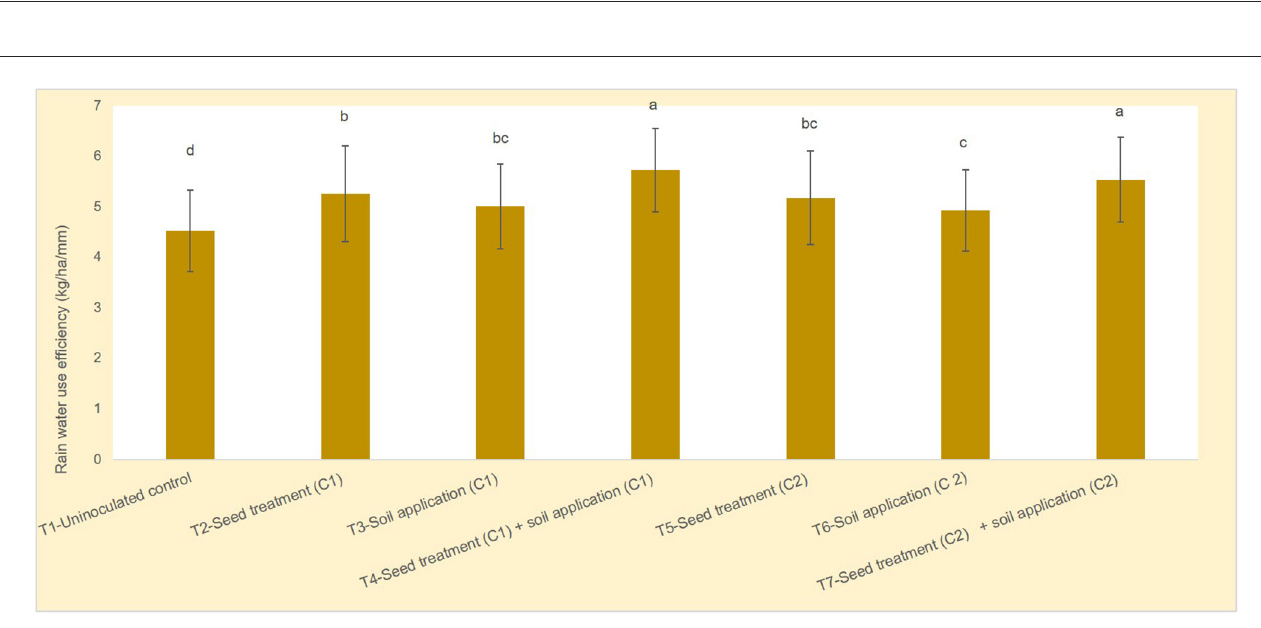
FIGURE2 Effect of microbial consortia on rain water use efficiency of maize. p = 0.00; error bars indicate standard error. The different alphabets on the top of error bars indicate the significant